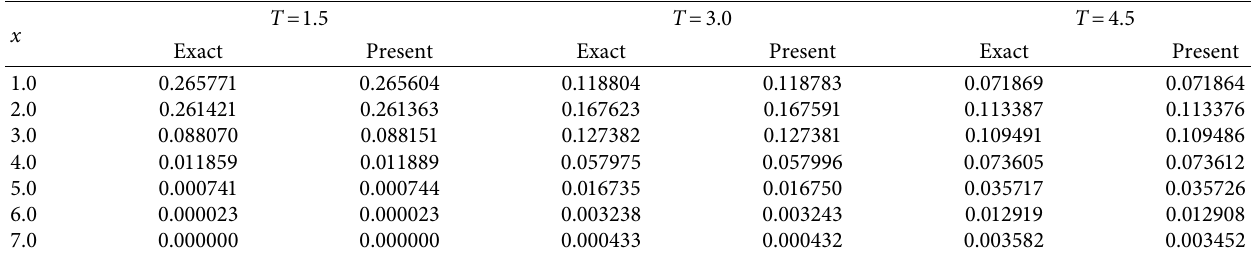
Table 1: Solution of the equation at diferent time levels for the frst test problem.